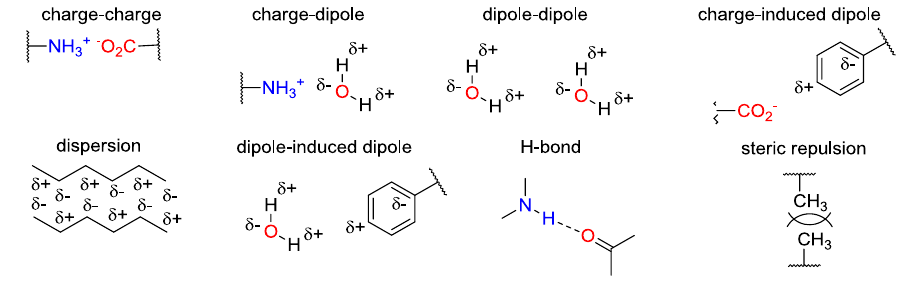
Figure 9. Possible non-covalent interactions, see Ref.